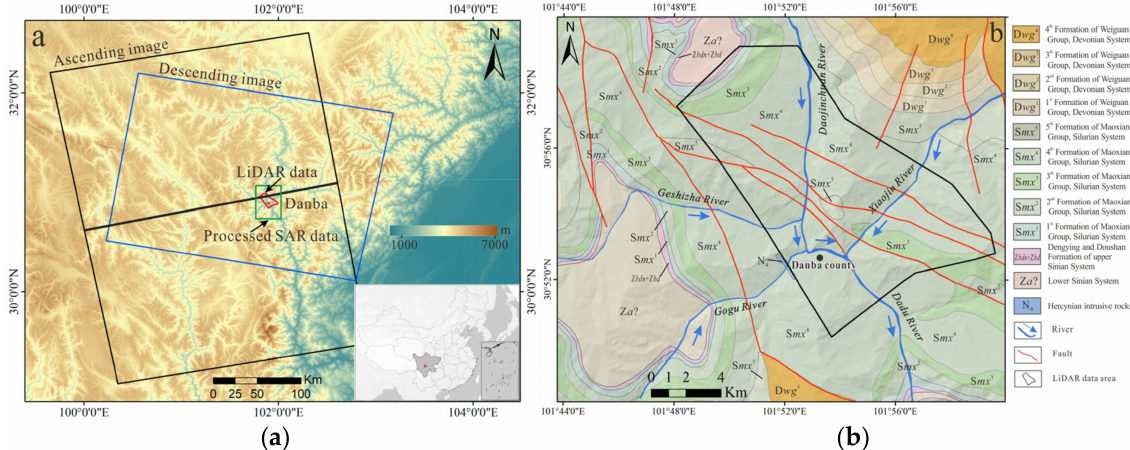
Figure 2. ( a ) Location of Danba County and coverage of the SAR datasets; ( b ) tectonic and geological map of the study